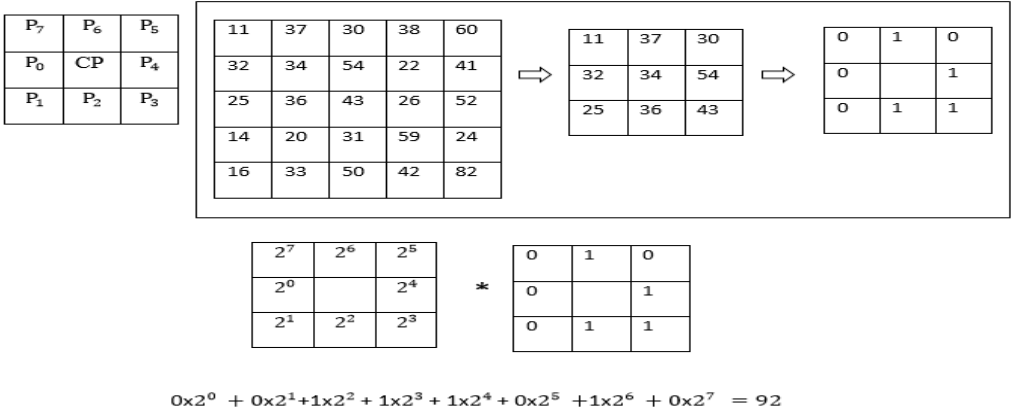
Figure 2. Calculation of Local Binary Pattern for every